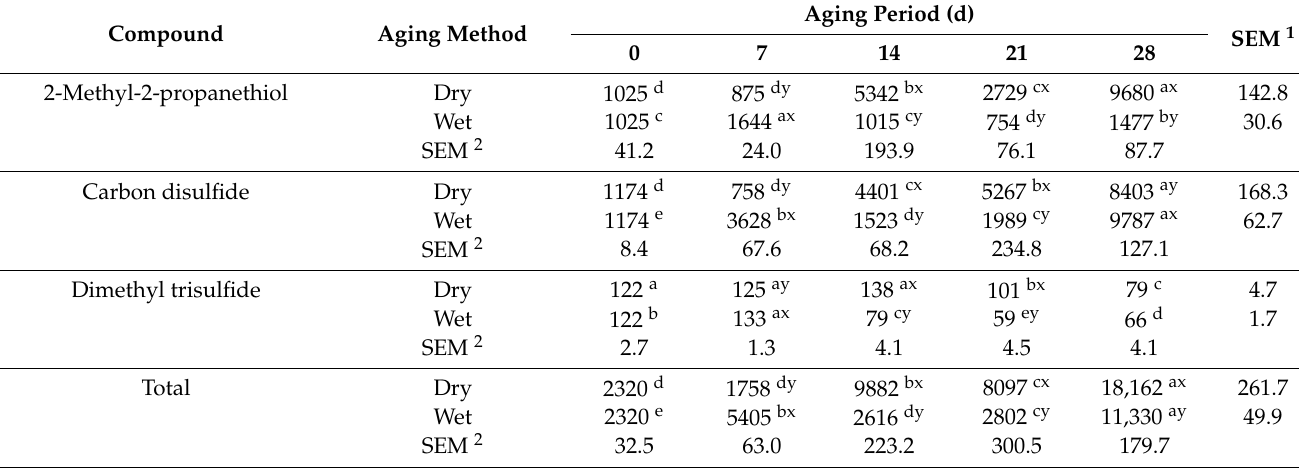
Table 5. Peak area of S-containing compounds in beef during aging with different aging methods.